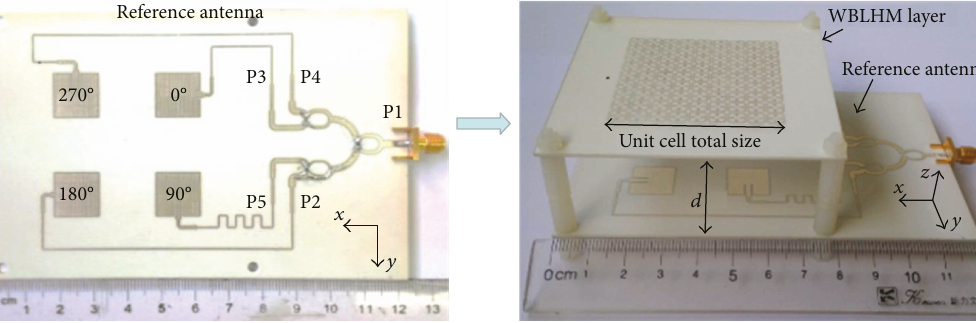
Figure 3: Wideband CP LHM antenna prototype.